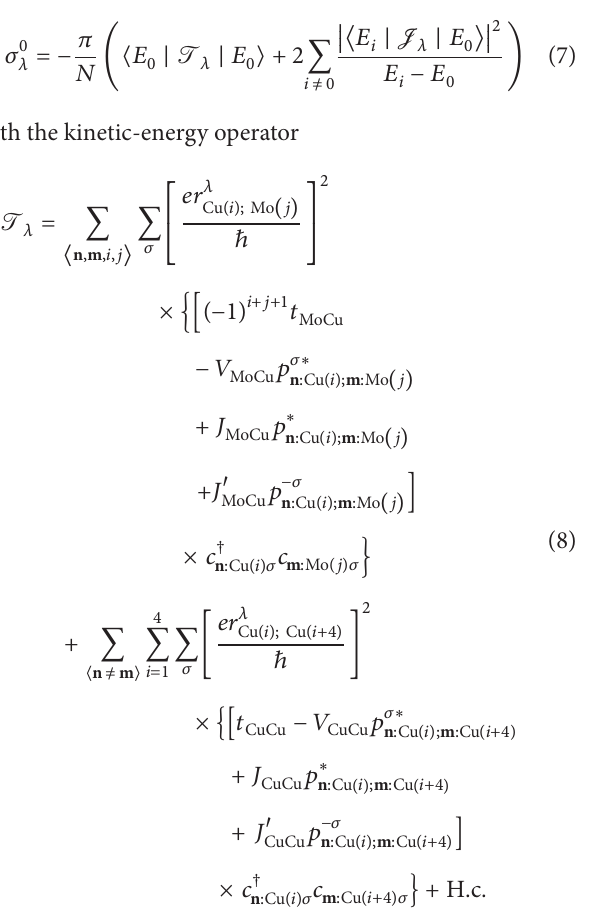
equal to | a | . The Drude spectral weight [41, 42] in (4) is given